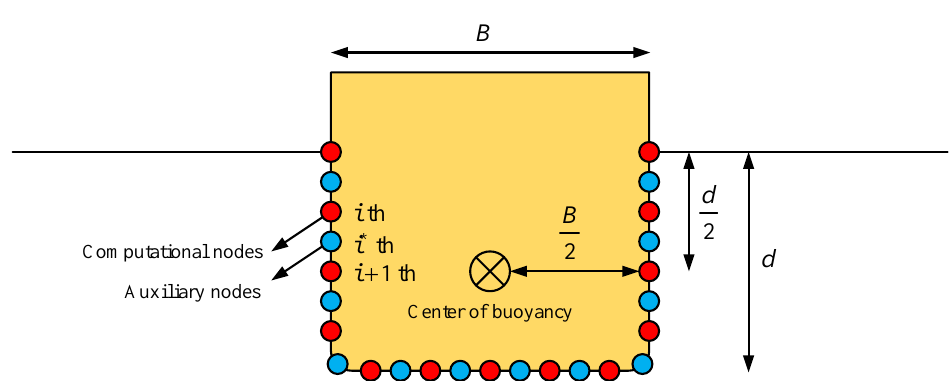
Figure 2. Schematic diagram of the computational methods for the hydrodynamic loads acting on a surface-piercing